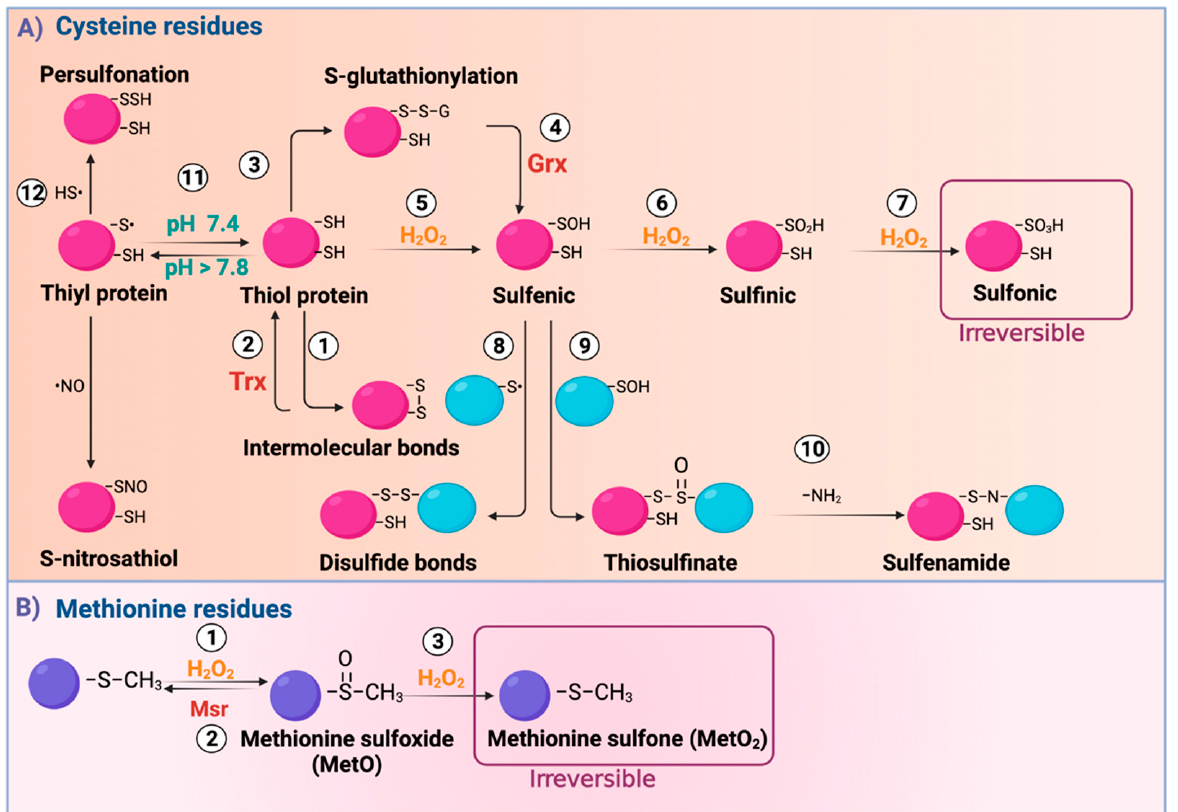
Figure 1. Reactive oxygen species (ROS) induce modifications in cysteine (Cys) and methionine (Met) residues. ( A ) ROS oxidize Cys residues in its thiol form, named thiol (SH) protein, forming oxidize Cys residues in its thiol form, named thiol (SH) protein, forming (1) intermolecular bonds, (2) reversed by (1) intermolecular bonds, (2) reversed by thioredoxin (Trx), or (3) S-glutathionylation (R–SSG). R– SSG can be reversed by (4) the glutaredoxin (Grx) enzyme, acquiring a sulfenic (R–SOH) form.